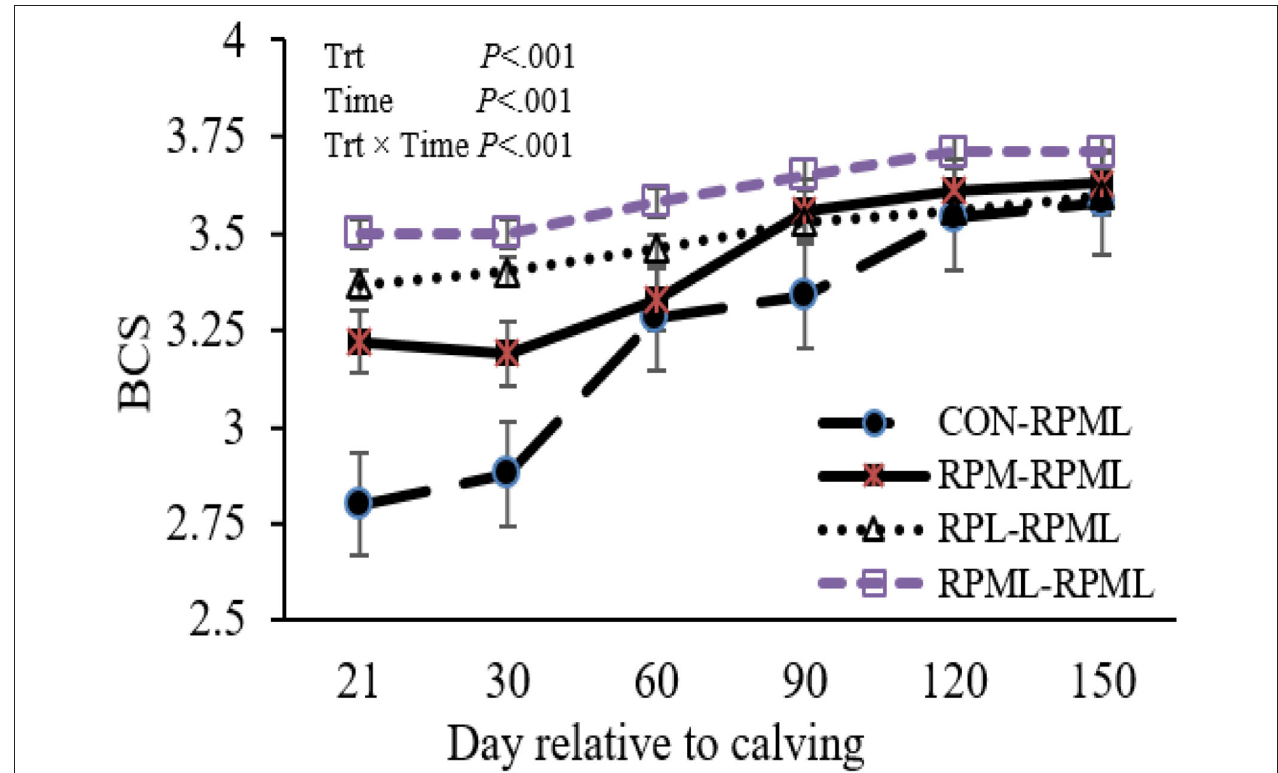
FIGURE 2 | Effect of supply ruminally protected Met and Lys to transition and milking dairy cows on body condition score. Values are means; standard errors are represented by vertical